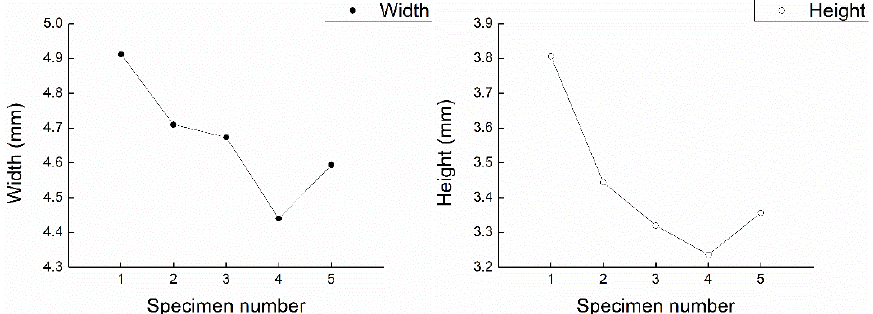
Figure 4. Average width and height of specimens by wire and arc additive manufacturing with different heat input.